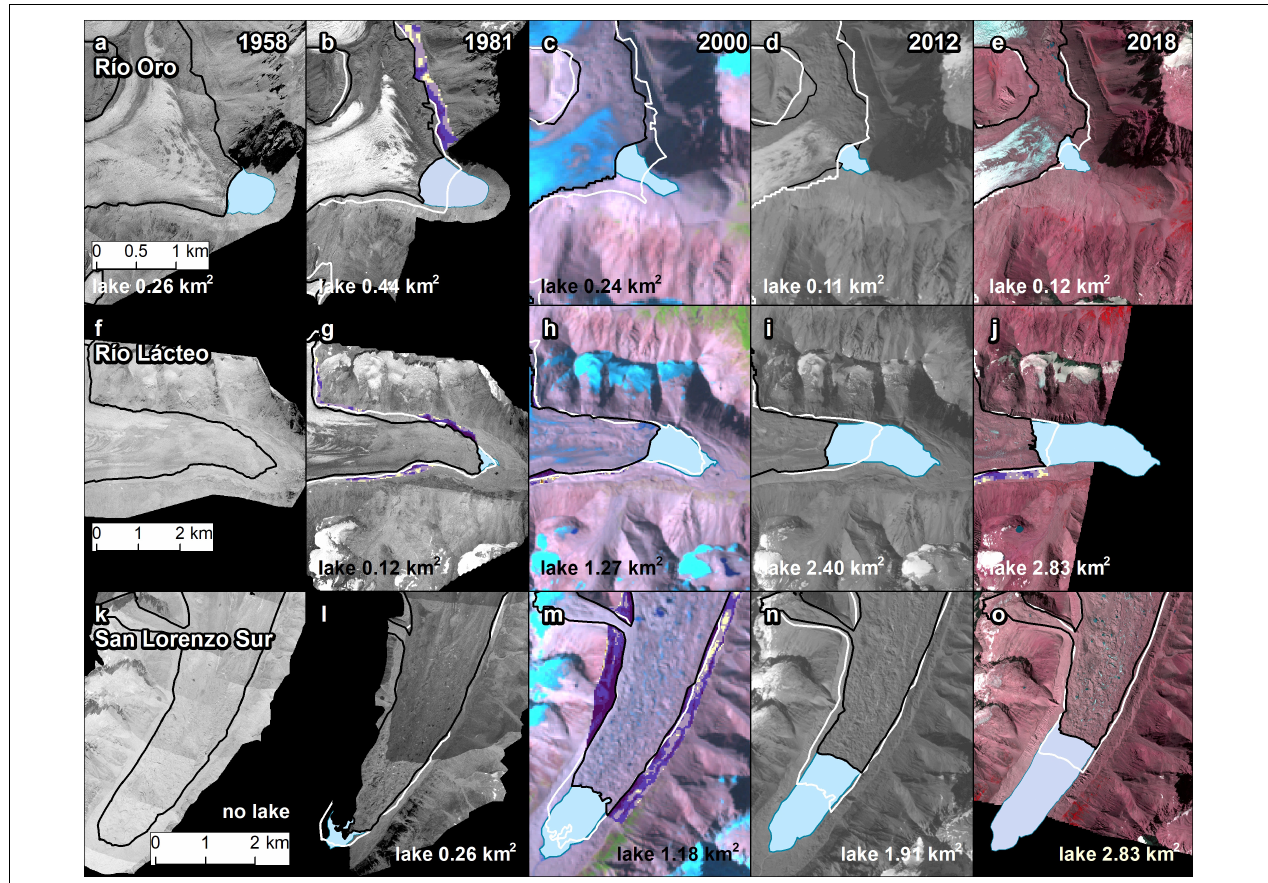
FIGURE 8 | Glacier outline and proglacial lake changes in the Río Oro (a–e) , Río Lácteo (f–j) , and San Lorenzo Sur (k–o) glaciers. Black lines represent glacier outlines from the actual survey year on each panel and white lines correspond to the previous survey year. The bluish areas adjacent to glacier outlines show the degradation of lateral moraines in response to glacier downwasting (the color scheme is the same as in Figure 3